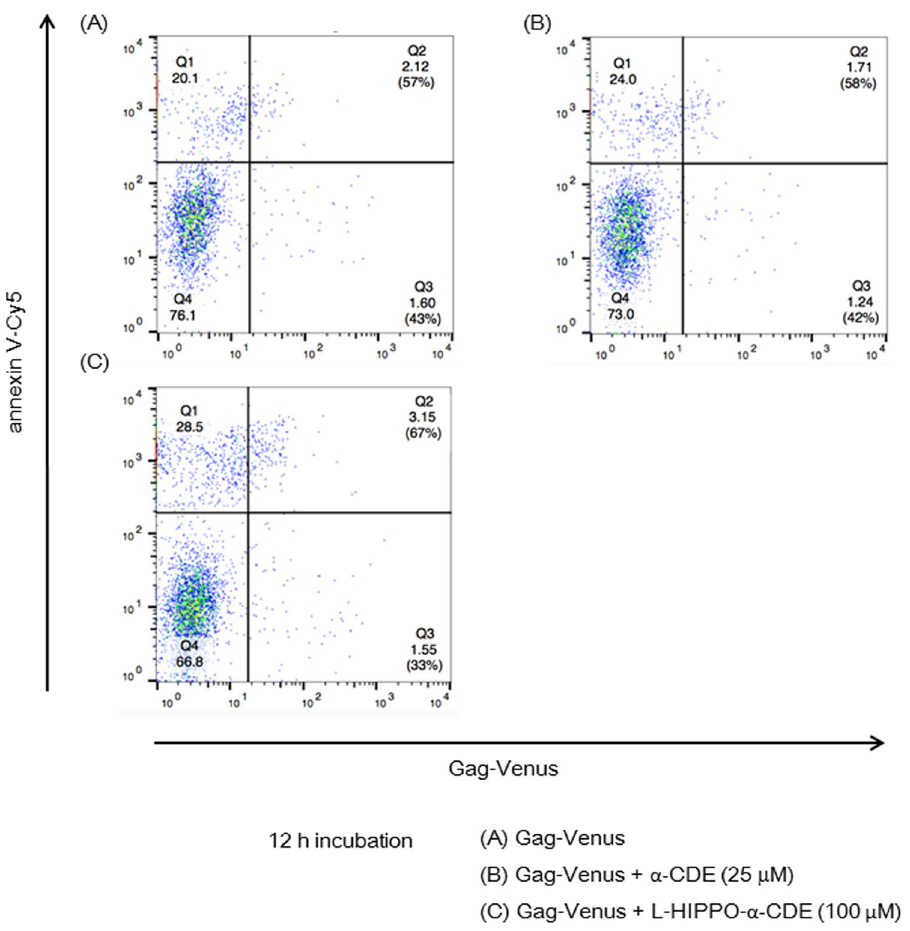
Figure 4. Apoptotic effect of L-HIPPO- α -CDE with HIV-1 protein in T cells. Jurkat cells were transfected with pNL4-3/GagVenus, and after 1 d, a complex prepared from L-HIPPO (100 μ M) and α -CDE (25 μ M) (L-HIPPO- α -CDE) was added. After a further 12 h incubation, FACS analysis using annexin V-Cy5 was